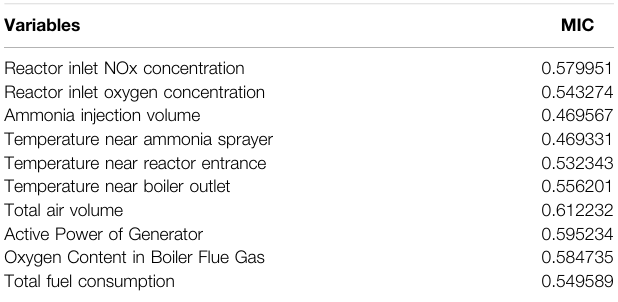
TABLE 1 | The results of MIC